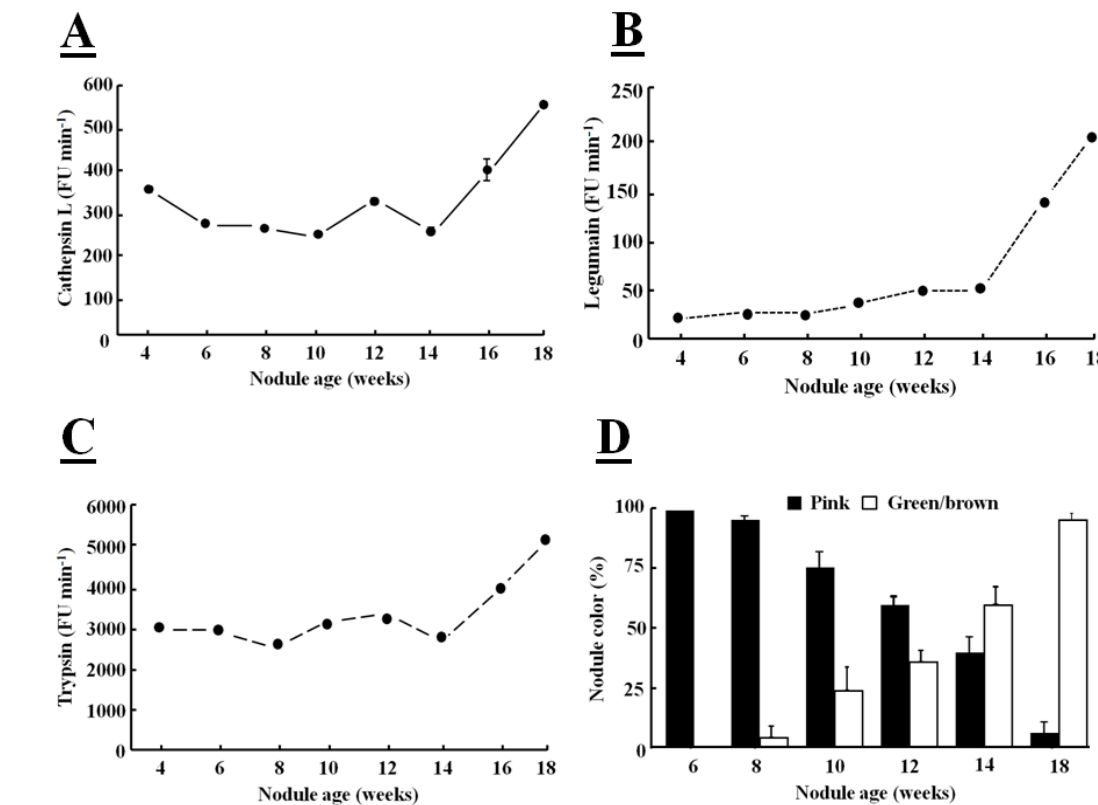
Figure 4. Determination of cathepsin Ll-like ( A ), legumain-like ( B ), trypsin-like ( C ) protease activities in soybean crown nodules (cultivar Prima 2000) and crown nodules color ( D ) over a period of 18 weeks. Cathepsin L-like activity with substrate Z-Phe-Arg-MCA was measured in 50 mM sodium phosphate buffer, pH 6.0, containing 5 mM L -cysteine, legumain-like cysteine protease activity with substrate Z-Ala-Ala-Asn-MCA measured in buffer containing 39.5 mM citric acid, 121 mM Na HPO , 1 mM DTT, 1 mM EDTA, and 0.01% CHAPS at pH 7.0 and 2 4 trypsin-like activity with substrate Z-Arg-MCA in 100 mM Tris-HCl buffer at pH 8.0. Hydrolysis of the substrate was monitored using a hydrolysis progress curve [44]. Hydrolysis was monitored at 25 °C with a spectro-fluorometer (BMG FluoStar Galaxy) with excitation and emission at 340 ± 10 nm and 450 ± 10 nm, respectively. The reaction was measured over a period of 20 min. Reaction rates represented by the slope of the curve were measured as Fluorescence Units (FU/min). All reactions were performed in triplicate. For nodule color pink color indicates active leghemoglobin, greenish/brown color inactive leghemoglobin. Color values shown represent the mean of four individual experiments ± SE and protease activity data represent the mean ± SE of three individual activity measurements with 2 µg of nodule protein extract added to each